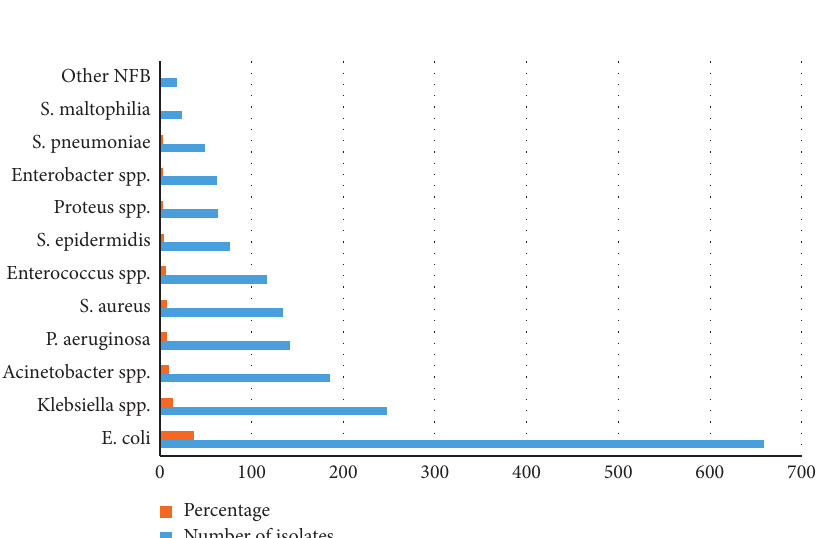
Figure 1: Frequency of bacteria isolated from clinical samples of patients with infections; NFB: nonfermentative